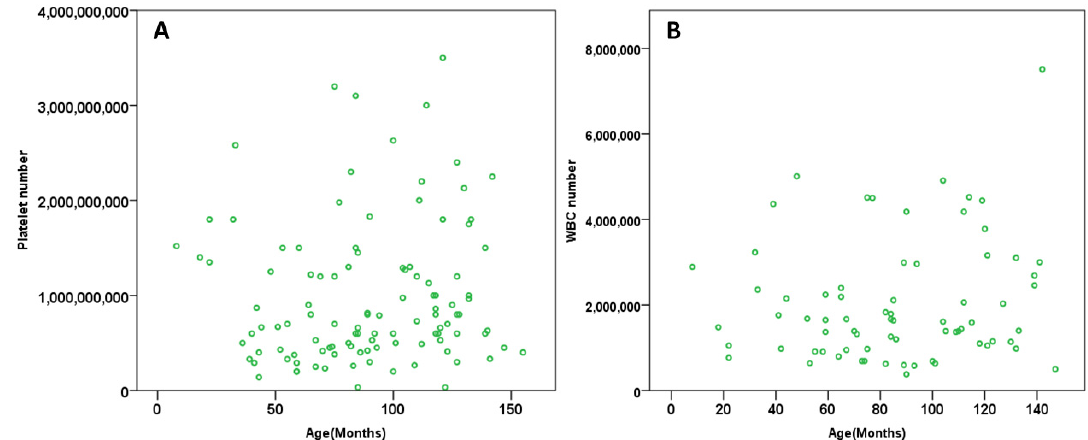
Figure 2. The scatter dot plot demonstrating the relationship between platelet number and age of the patient (months). In relation to the age of the patient, Pearson´s test did not show any correlation on platelet count ( p = 0.465, r = 0.07) ( A ) and WBC count (p = 0.283 , r = 0.141) ( B ) across all the patients included in this study.